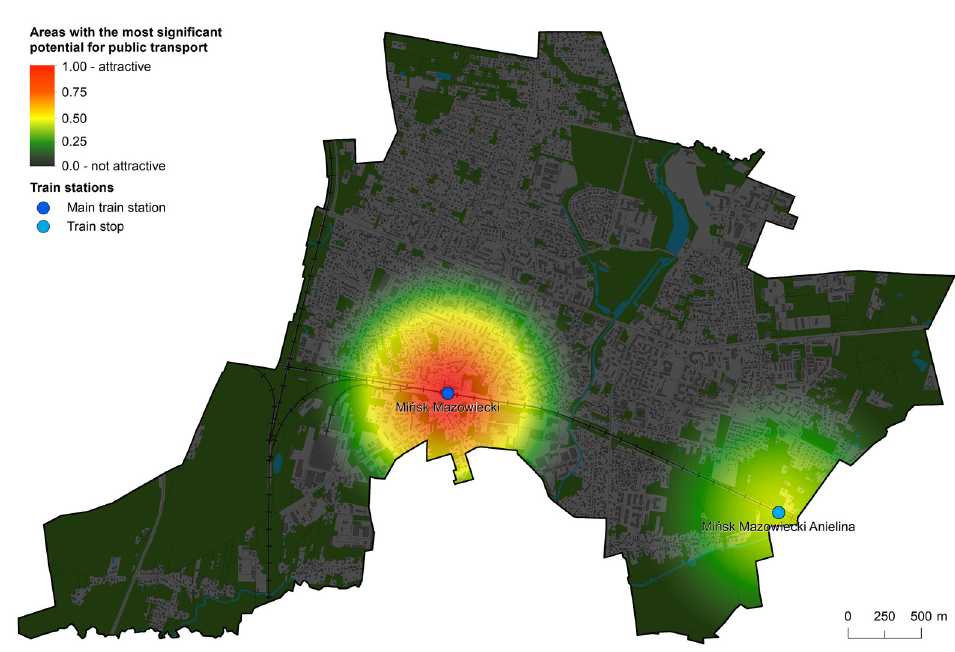
Fig. 3. Areas with the most significant potential for public transport in means of train transit